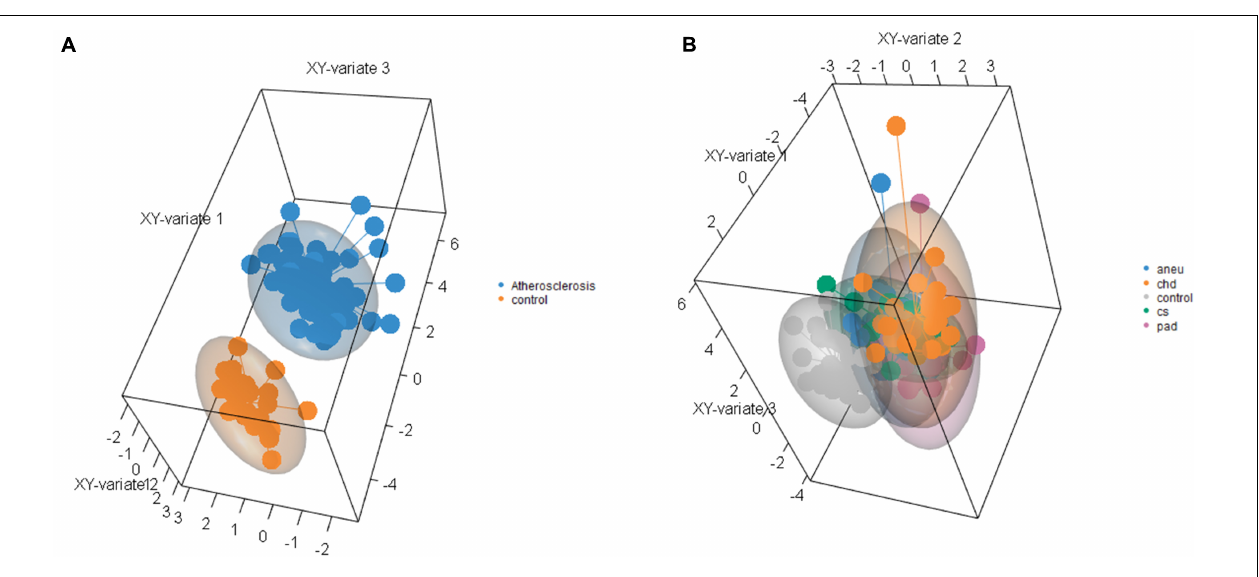
FIGURE 6 | Results of sparse partial-least-squares discriminant analysis for two components. (A) Comparing athero group and control group and (B) comparing subgroups and control; aneu = abdominal aneurysm; chd = coronary heart disease; cs = carotid stenosis; pad = peripheral artery